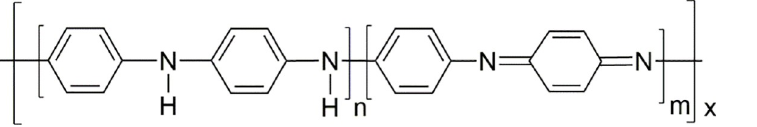
Fig 2. Representation of the proposed structure of polyaniline after laccase-assisted polymerization mediated by HBT [25].